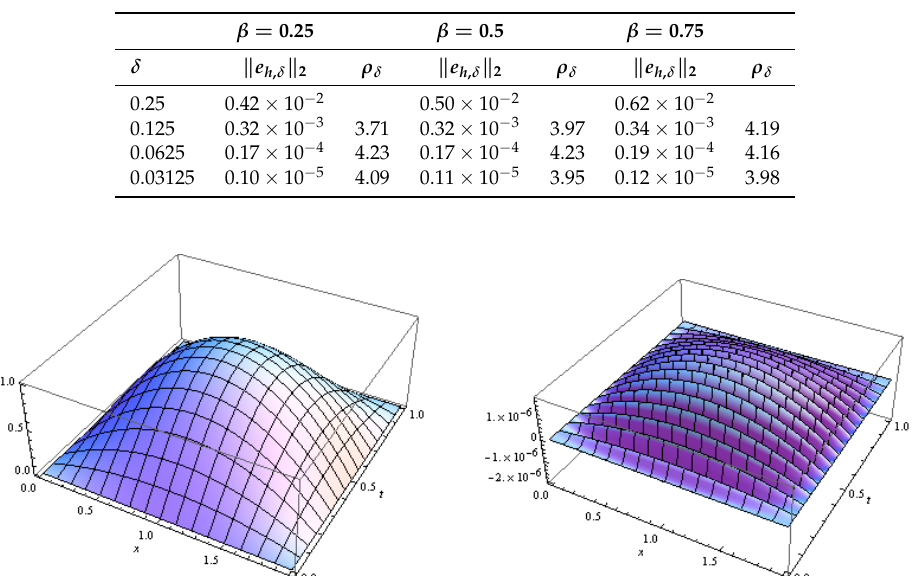
Table 4. Test 2: The L 2 -norm of the error and the numerical convergence order ρ δ as a function of the time step δ for different values of the order β of the fractional derivative.